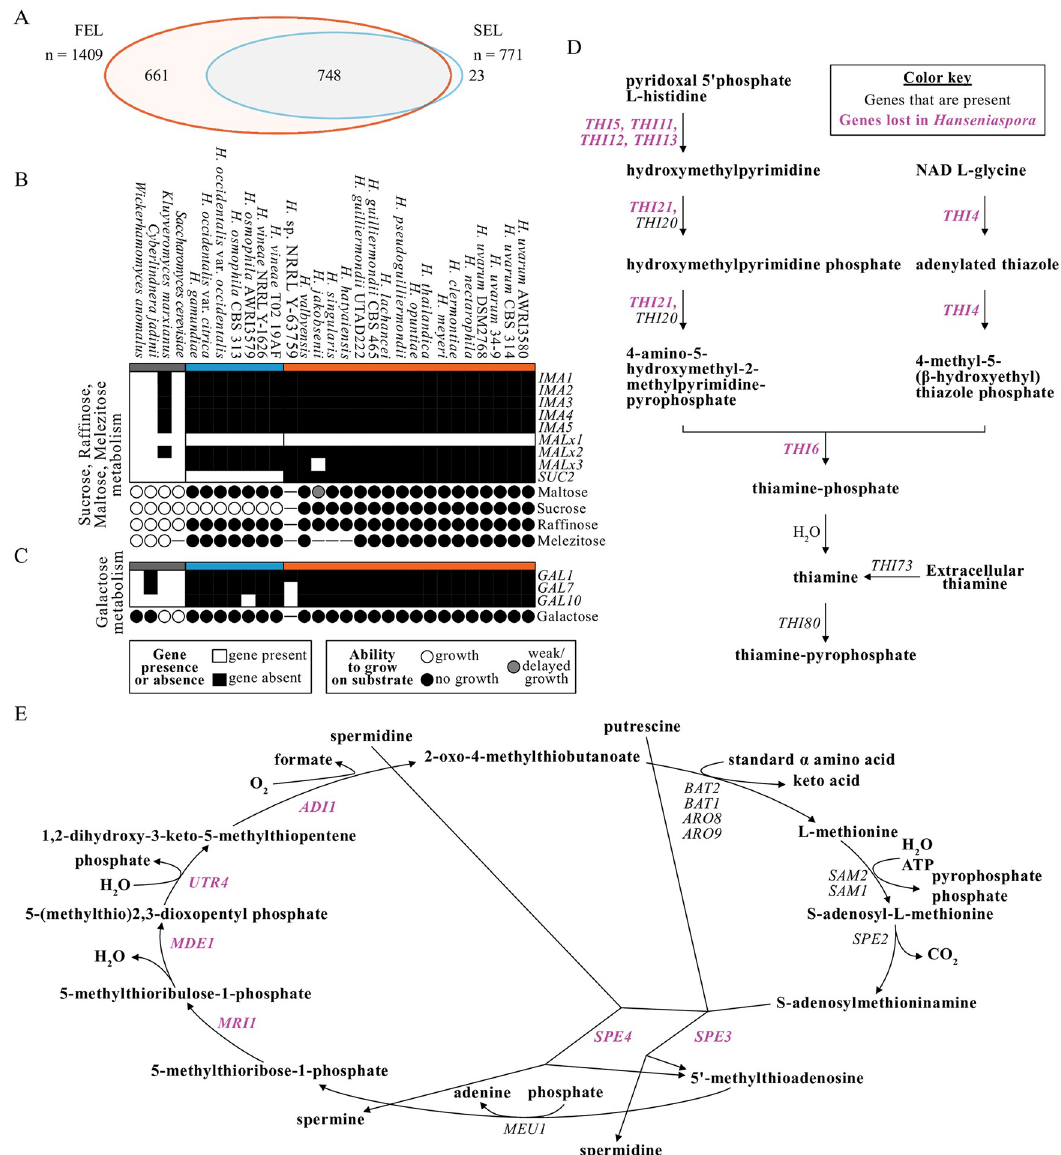
Fig 2. Gene presence and absence analyses reflect phenotype and reveal disrupted pathways. (A) Examination of gene presence and absence (see Methods) revealed numerous genes that were lost across Hanseniaspora . Specifically, 1,409 were lost in the FEL, and 771 genes were lost in the SEL. A Euler diagram represents the overlap of these gene sets. Both lineages have lost 748 genes, the FEL has lost an additional 661, and the SEL has lost an additional 23. (B) The IMA gene family ( IMA1 – 5 ) encoding α -glucosidases, MAL ( MALx1 – 3 ) loci, and SUC2 are associated with growth on maltose, sucrose, raffinose, and melezitose. The IMA and MAL loci are largely absent among Hanseniaspora with the exception of homologs MALx1 , which encode diverse transporters of the major facilitator superfamily whose functions are difficult to predict from sequence; as expected, Hanseniaspora spp. cannot grow on maltose, raffinose, and melezitose, with the sole exception of H . jakobsenii , which has delayed/weak growth on maltose and is the only Hanseniaspora species with MALx3 , which encodes a homolog of the MAL -activator protein. (C) The genes involved with galactose degradation are largely absent among Hanseniaspora species, which correlates with their inability to grow on galactose. Genes that are present are depicted in white, and genes that are absent are depicted in black. The ability to grow, the ability to weakly grow/exhibit delayed growth on a given substrate, or the inability to grow is specified using white, gray, and black circles, respectively; dashes indicate no data. (D) Most genes involved in the thiamine biosynthesis pathway are absent among all Hanseniaspora . (E) Many genes involved in the methionine salvage pathway are absent among all Hanseniaspora . Absent genes are depicted in purple. figshare: https://doi.org/10.6084/m9.figshare.7670756.v2. ADI , Acireductone Dioxygenase; ARO , AROmatic amino-acid requiring; AWRI, Australian Wine Research Institute; BAT , Branched-chain Amino-acid Transaminase; CBS, Centraalbureau voor Schimmelcultures; DSM2768, Dutch State Mines 2768; FEL, faster-evolving lineage; GAL , GALactose